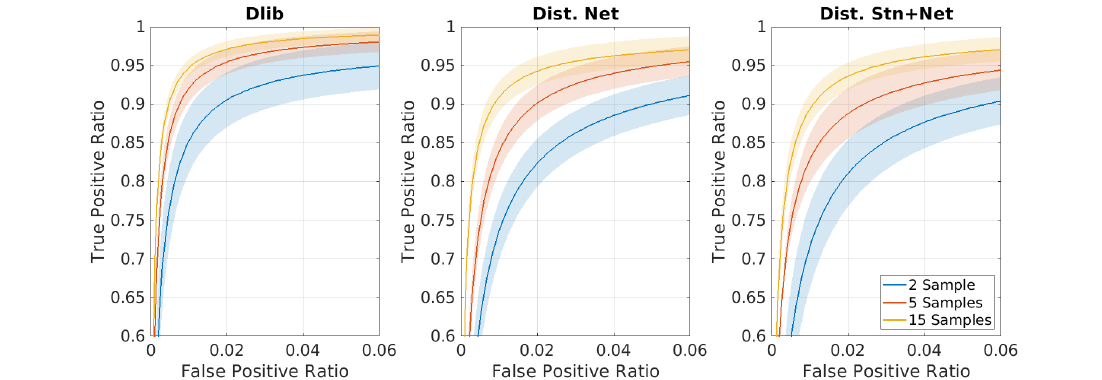
Figure 10. Average ROC curves estimated from a ten-fold cross-validation procedure on multiclass classifier. Each classifier is trained using a fixed amount of classes (30) and a varying number of training sample, using the features generated by ’dlib-resnet-v1’, ‘distilled-net’, ‘distilled stn+net’. Note that the graphs are highly zoomed portions of the entire curve.